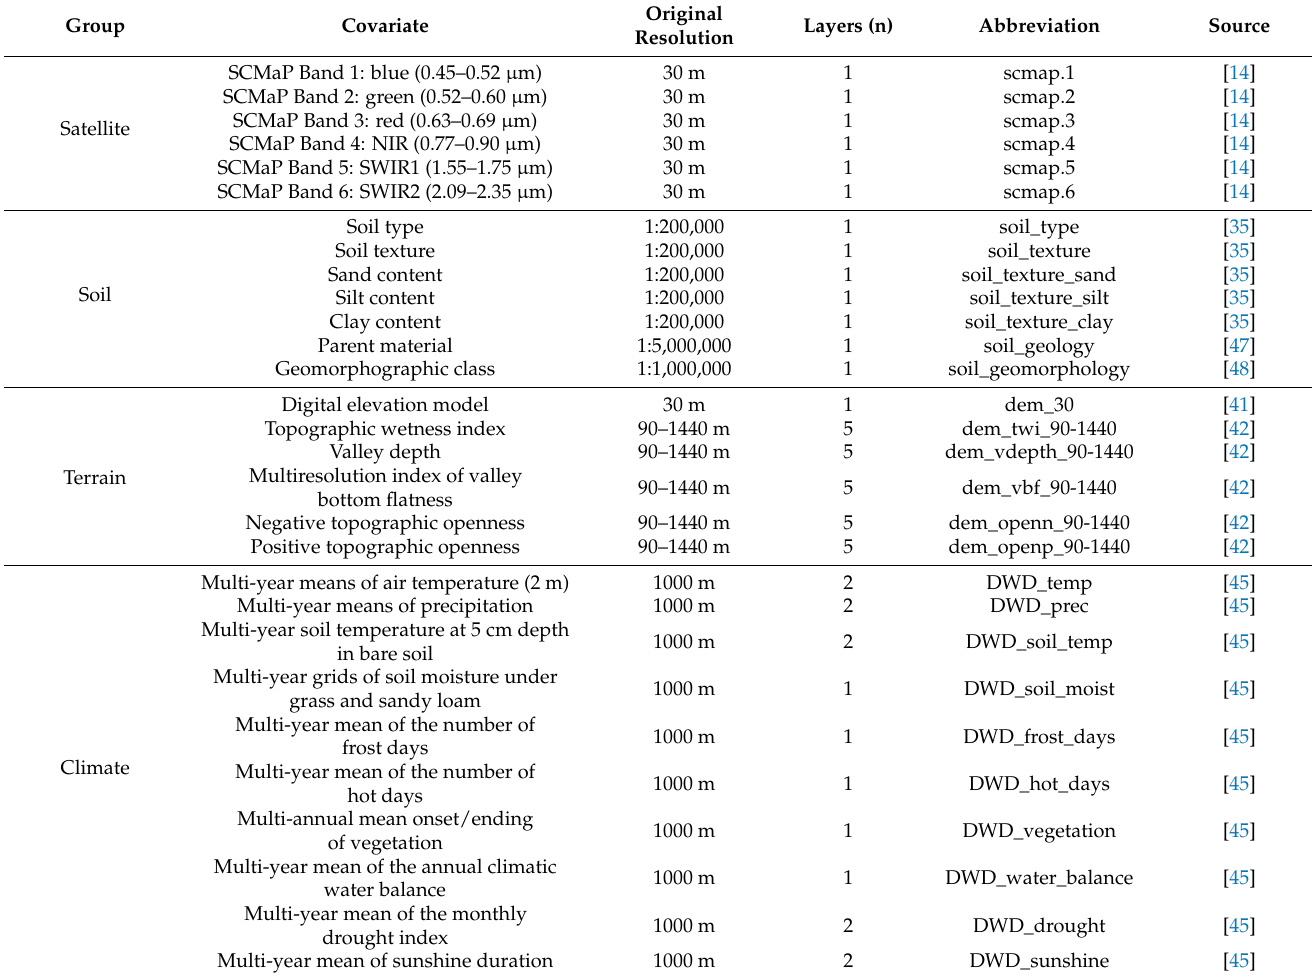
Table 3. Overview of all